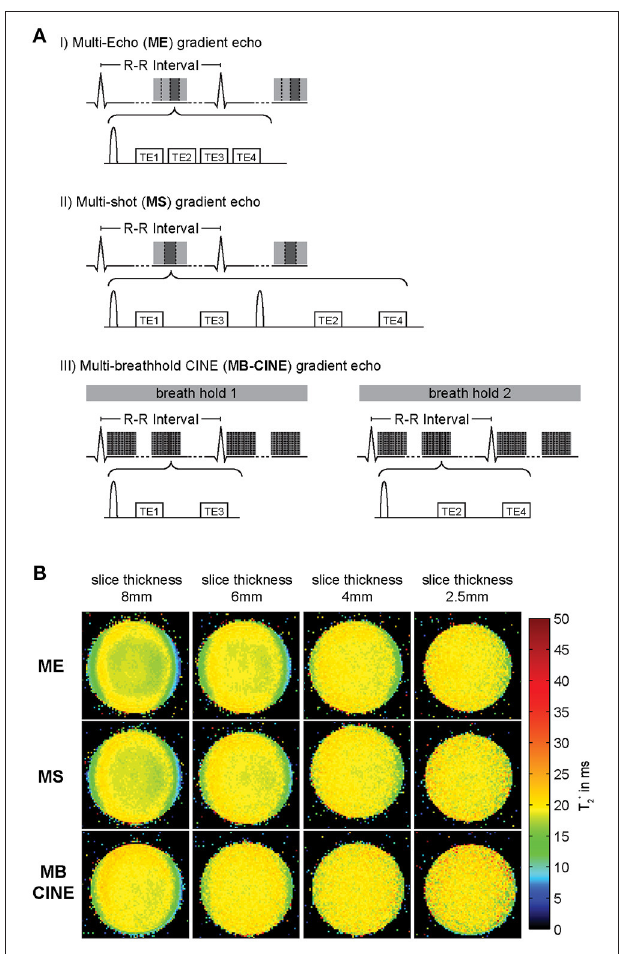
FIGURE 5 | Acquisition schemes used for T 2 * weighted imaging/mapping and corresponding T 2 * maps. (A) (I) multi echo gradient echo (MEGRE) acquisition, (II) multi shot (MS) interleaved multi gradient echo acquisition, (III) multi breath hold CINE (MB-CINE) interleaved multi gradient echo acquisition. (B) Comparison of T 2 * maps derived from a homogenous phantom resembling myocardial tissue acquired using the three different approaches and slice thicknesses from 8 to 2.5 mm. All acquisition strategies provide similar T 2 * maps. Through plane dephasing is reduced for lower slice thickness (adapted from Hezel et al.